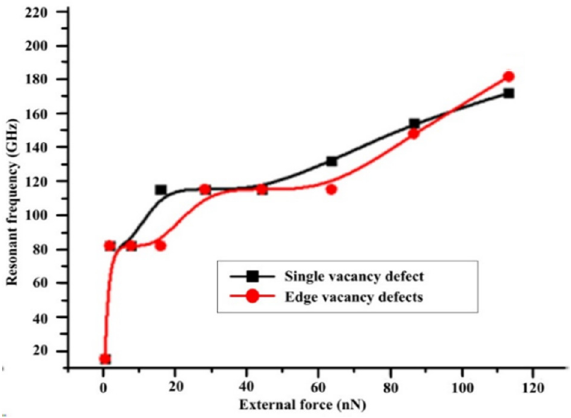
Figure 7. Resonance frequency as a function of external force with two different vacancy defects.